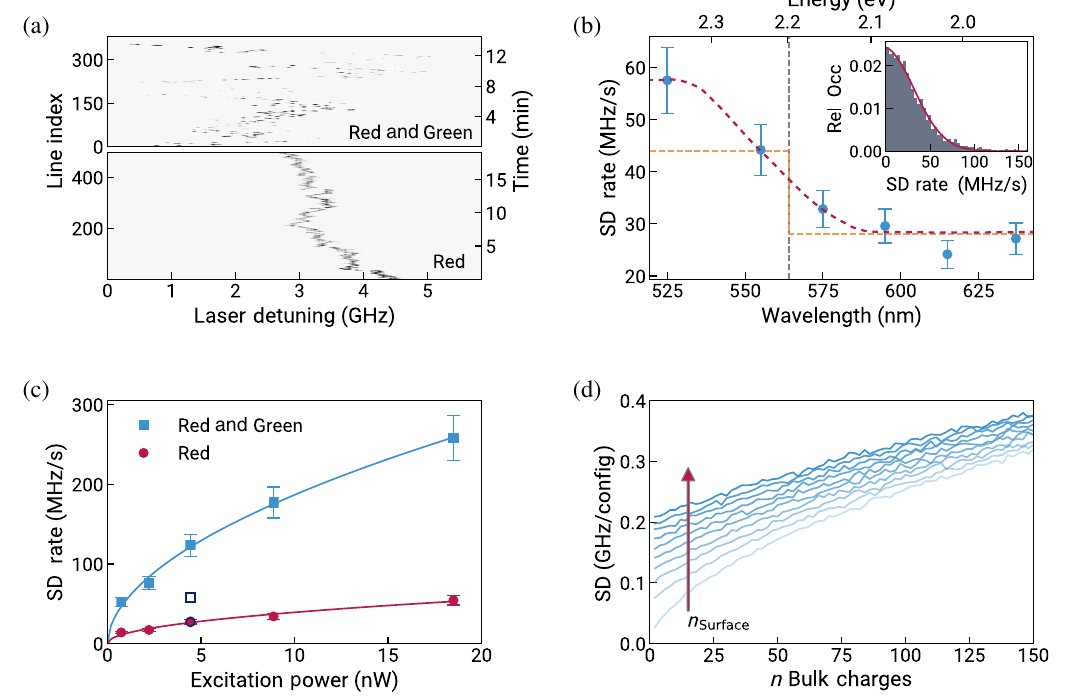
FIG. 3. Spectral diffusion dynamics (regime 2). (a) Hundreds of PLE scans performed with only resonant excitation laser irradiation (bottom) and with a mixture of resonant and green (525 nm) laser irradiation, with an equal ratio of a total power of 4 nW (top). While red laser irradiation induces a small drift of the ZPL resonance frequency, additional green laser light causes large spectral jumps. (b) Spectral diffusion (SD) rate measured for different excitation wavelengths. A two-color PLE scheme, involving resonant and off- resonant laser irradiation, is applied with a total power of 4 nW. The gray dashed line highlights the wavelength of 564 nm, which corresponds to the ionization energy of substitutional nitrogen defects. As a guide for the eye, the supposed spectral diffusion rate evolution is drawn, assuming bulk diamond containing only nitrogen defects (orange dashed line) and additional surface defects (red dashed line). Inset: relative occurrence of spectral shifts described by a normal distribution function. Here, the data excited with a mixture of resonant and 575 nm light are shown. (c) Spectral diffusion rate as a function of the total excitation power, recorded for resonant excitation and two-color excitation with 525 nm light (equal power ratio of on- and off-resonant excitation laser). The spectral bP a , with exponents a ¼ 0 . 49 for red diffusion rate scales like a square-root power law with respect to the excitation power: Γ SDR ¼ only and a ¼ 0 . 53 for two-color excitation. The filled markers correspond to data recorded after ten weeks at cryogenic temperatures, and the empty markers to data recorded directly after a warm-up and a second cooldown. (d) Monte Carlo approach with the spectral diffusion of the NV ZPL simulated by placing a certain number of bulk and surface charges at random positions and evaluating the resulting line shift, repeated over many iterations. The number of surface charges is increased from 2 to 452 in the direction of the arrow. Different charge configurations correspond to the fluctuating charge environment during repeated PLE line scans. The increase in spectral diffusion follows an approximate square-root power law by increasing the number of